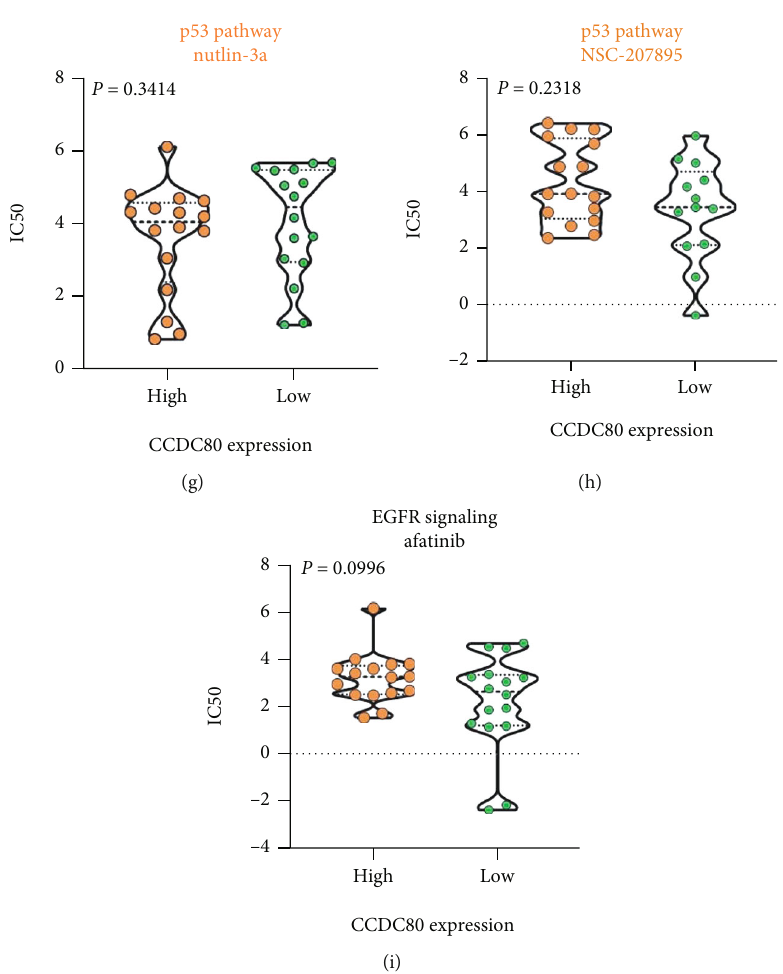
Figure 10: Violin plots visualizing the di ff erences of estimated half maximal inhibitory concentration (IC50) of compounds between high- and low- CCDC80 expression